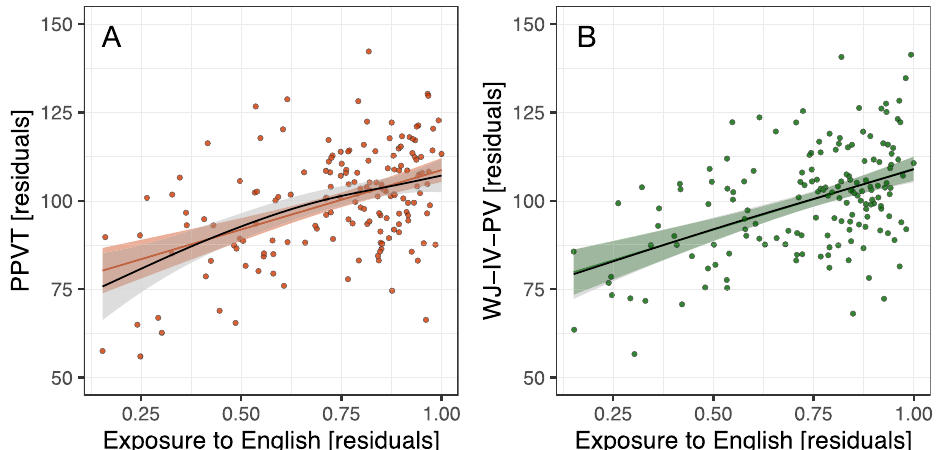
Figure 2. Relationship between the proportion of Cumulative Length of Exposure to English and ( A ) receptive (PPVT) and ( B ) expressive vocabulary scores (WJ-IV-PV), both controlled for age, gender, SES and non- verbal intelligence, standardized and centered around 100 with SD = 15 for visualizations. Next to individual participants’ data, we present the linear (colored lines) and smooth (black lines) terms for Cumulative Length of Exposure to English. NB., the smooth term for Exposure to English in the WJ-IV-PV model in ( B ), overlaps almost fully with the linear fit. See Table S5 for details on the model comparison